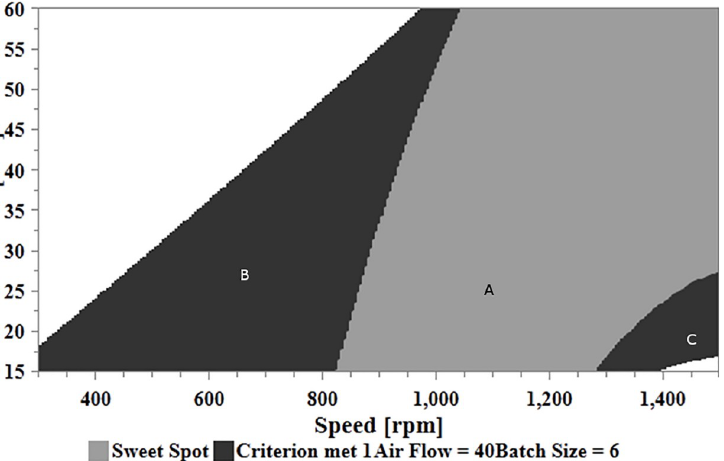
Fig 14. Sweet Spot for optimal ranges of the CPPs (speed and time) for the desired profile of CQAs (dissolution and content uniformity) while air flow and batch size were set at 40psi and 6g respectively.